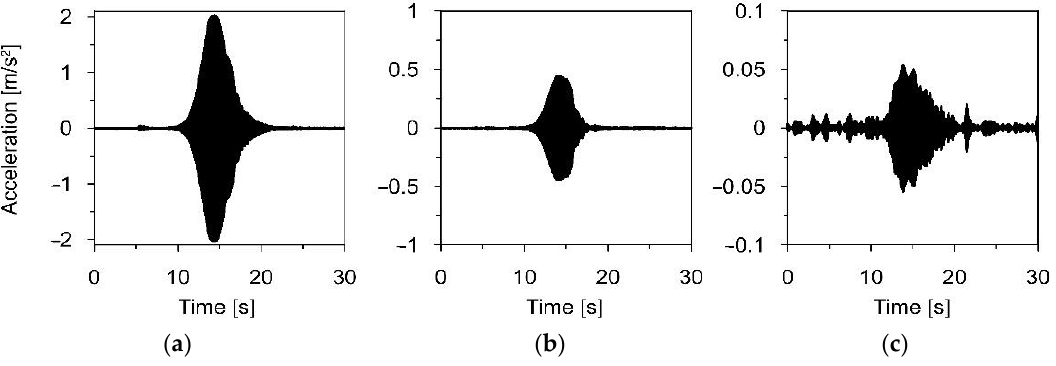
Figure 9. Acceleration component of the frequency 14 Hz registered at point: ( a ) P1, ( b ) P2, ( c ) P3.